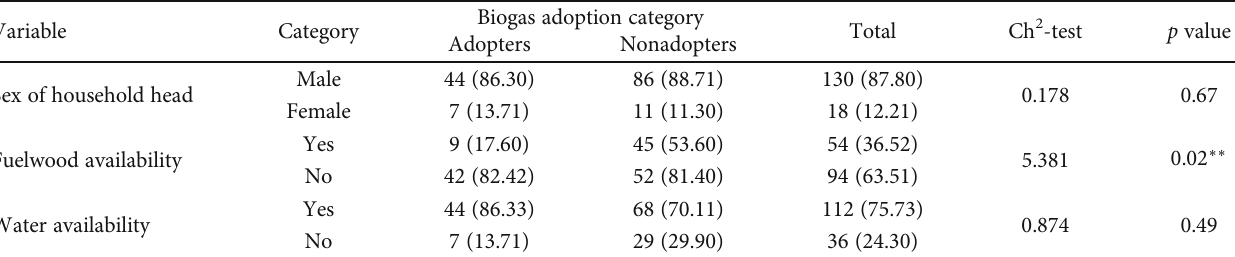
Table 2: Results of sex of sample household heads, availability of fuelwood and water